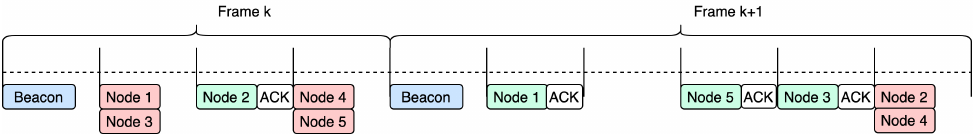
Figure 7. Sequence diagram for FC-TDMA